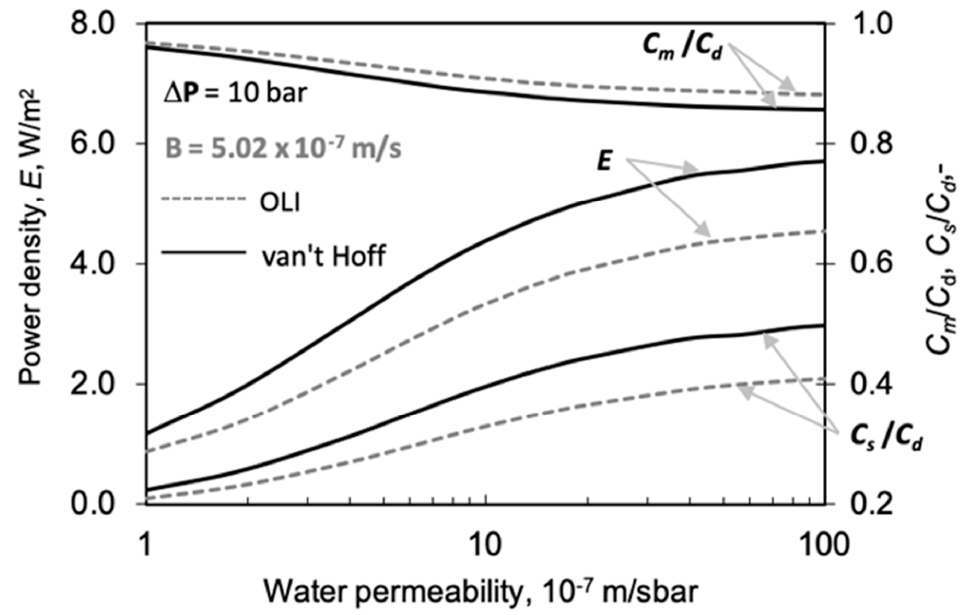
Figure 8. Power density and concentration of the membrane active layer as a function of the water permeability (constant parameters are given in Table 2).